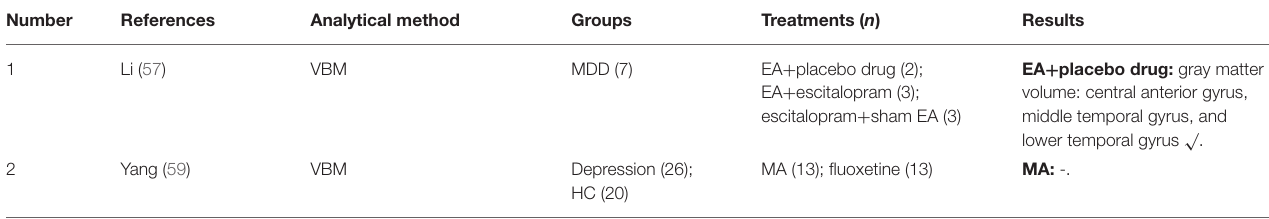
TABLE 5 | The sMRI studies of acupuncture on depression.